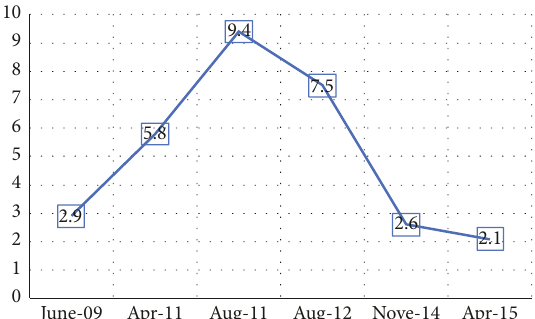
Figure 2: Comparison between CRP levels during application of omalizumab. The variation of protein levels does not correlate with the clinical manifestations of the patient and IgE levels.